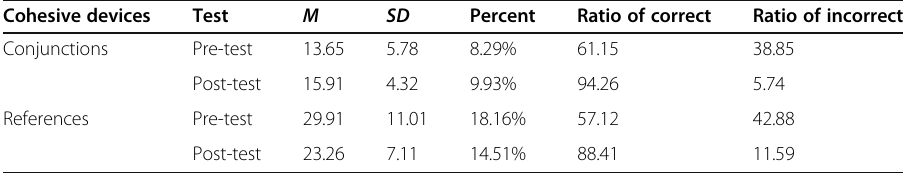
Table 6 Frequency, proportion, and ratio of correct/incorrect employment of conjunctions and